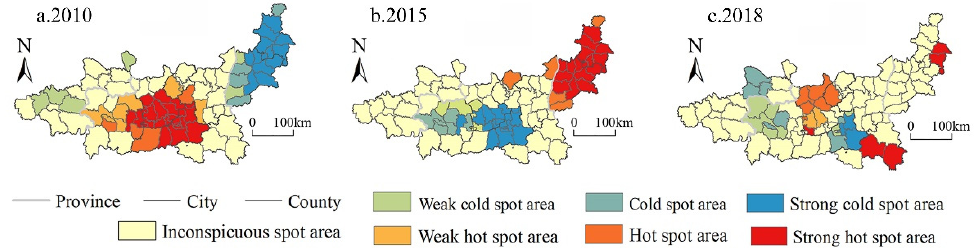
Figure 7. Spatial agglomeration characteristics of human well-being in Guanzhong Plain urban agglomeration from 2010 to 2018.